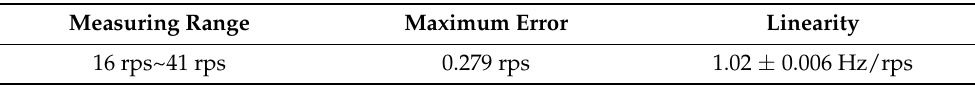
Figure 10. The measured rotational speed of an electric fan under different DC voltages for the synchronous detection and LED detection methods. Table 3. The specifications of the LC rotational speed measurement method.